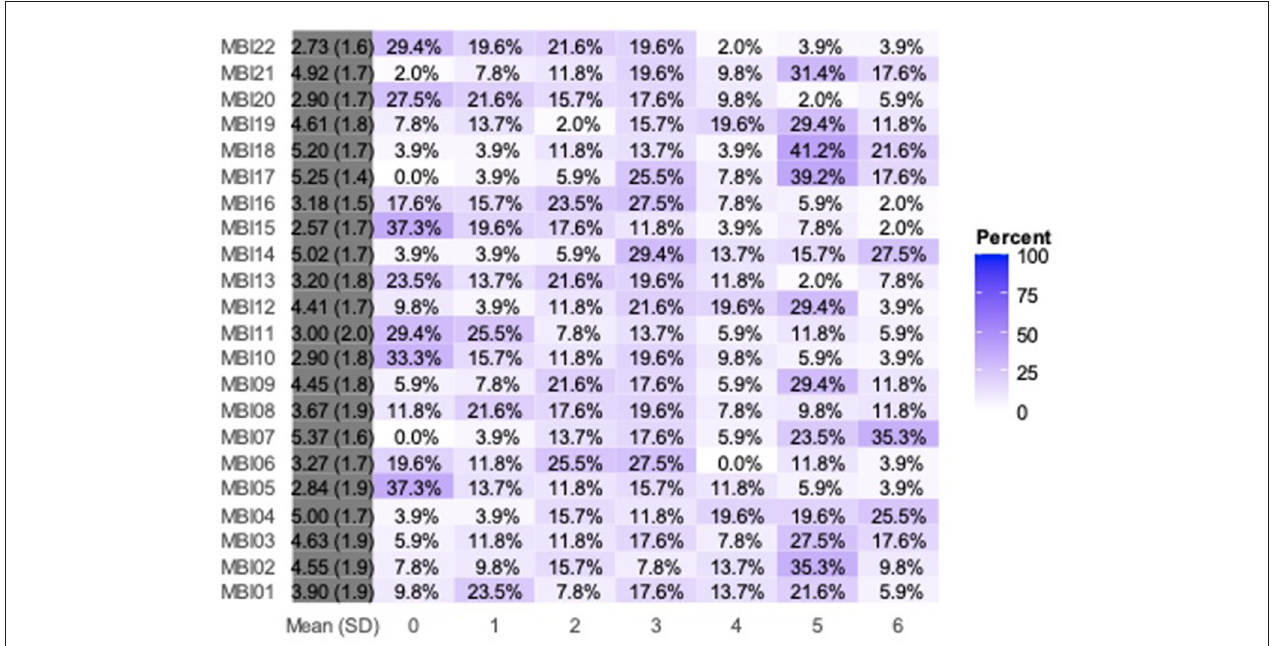
EI score. Exercise level also showed a statistically significant association with the EI score (B = 0.52, p < 0.05), indicating that the average EI score was 0.52 units higher in residents who exercised than in those who did not. None of the remaining sociodemographic characteristics were significant predictors of the EI score.